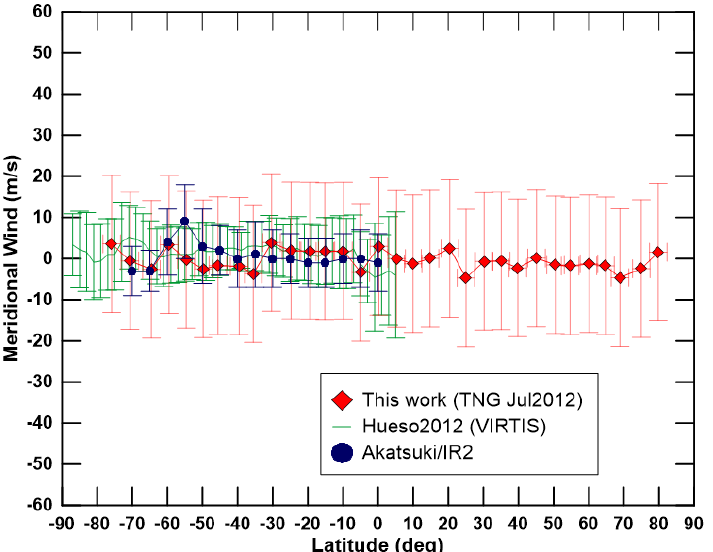
Figure 11. Latitudinal profile of the meridional wind: in red, we present the averaged meridional wind from the ground-based observations obtained with TNG/NICS from 11 to 13 July 2012. The results shown here are the outcome of a 5 ◦ binning in latitude. For comparison purposes we also present the meridional wind velocity results from Hueso et al. [21] using space-based Venus Express (VIRTIS) observations (shown in green). The blue dots are related with the Akatsuki/IR2 latitudinal profile of the meridional wind [22].